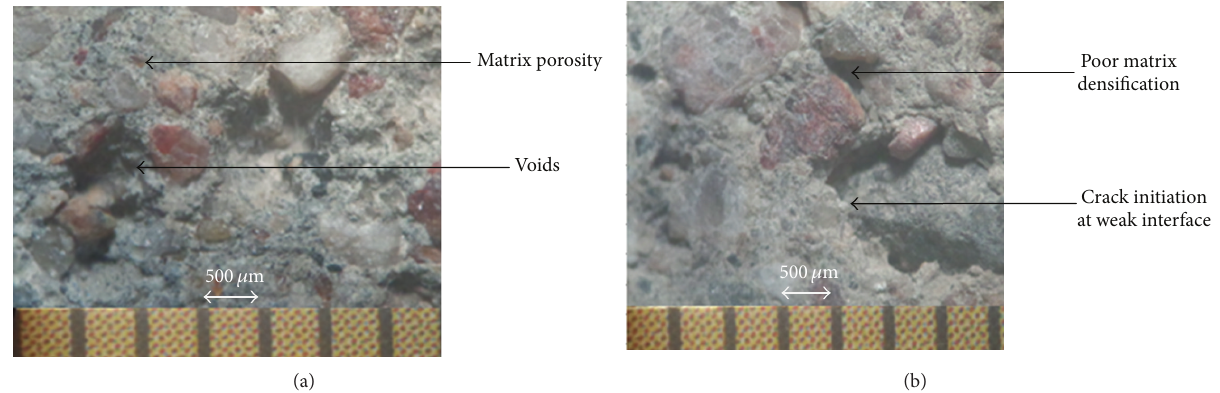
Figure 11: (a) Microscopic view of conventional concrete without initial stress (50x magnification). (b) Microscopic view of conventional concrete at 40% load (50x magnification).